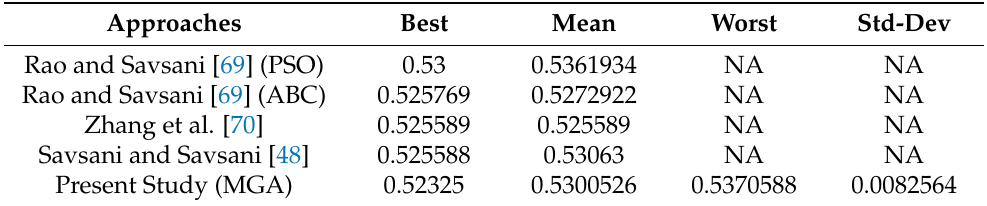
Table 14. Statistical results of different approaches for the planetary gear train design problem.